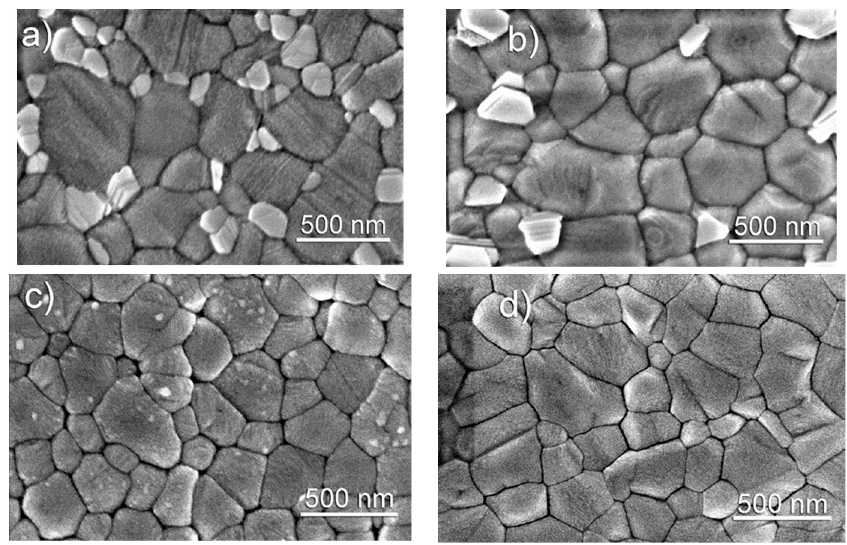
Figure 3. Top-view SEM images of formed perovskite layers with ( a ) 0; ( b ) 5; ( c ) 10; and ( d ) 15 % of Cs. Magnification is 100,000 × .